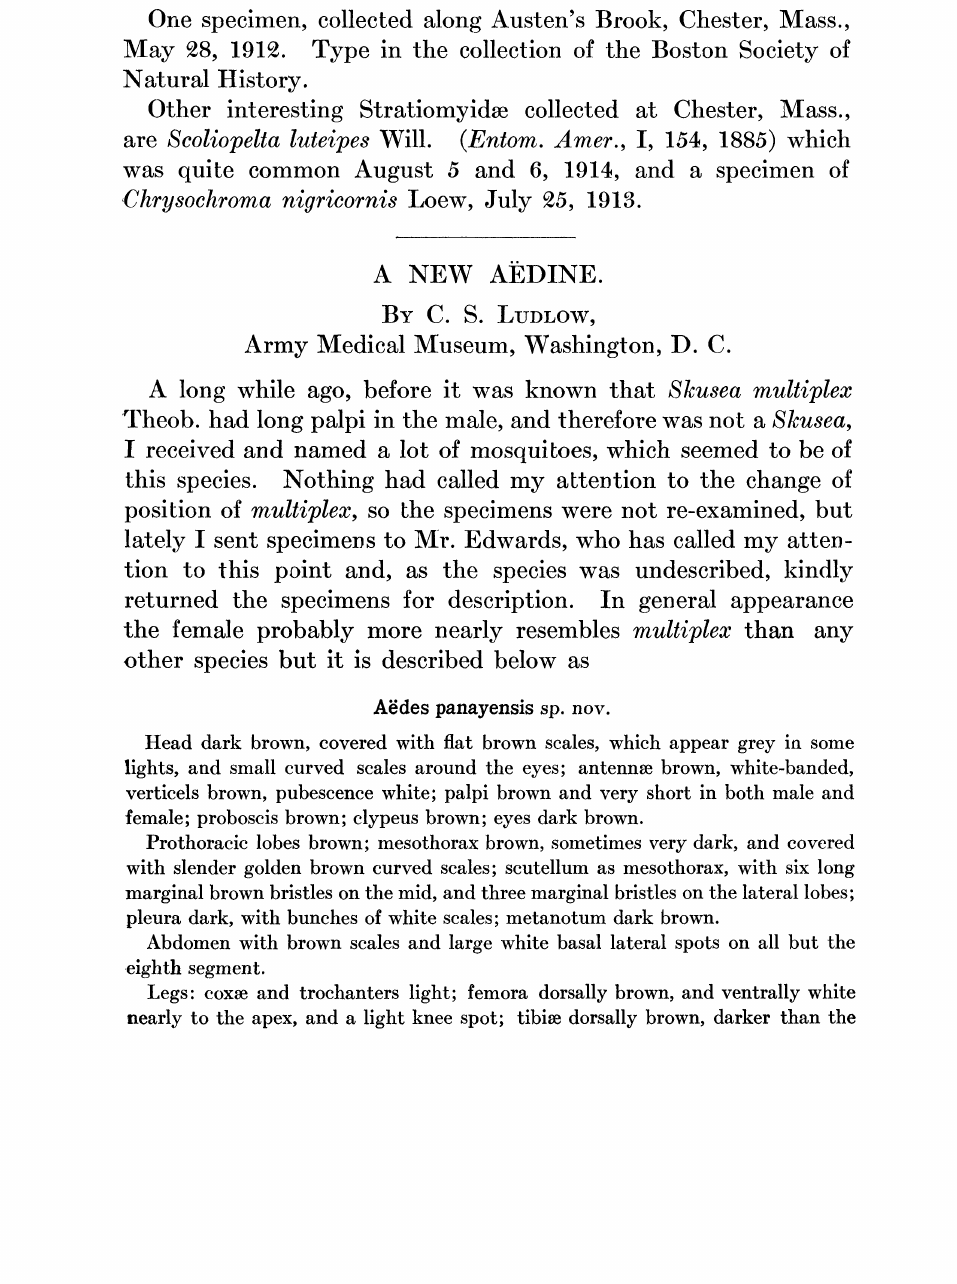
wing. Abdomen broad, about double the width of the thorax, the five segments ,shining, sparsely covered with whitish hairs. Halteres white, base of the knobs and stems brown. Legs black, knees, tips of the tibiae and the tarsi yellow, the last two joints of the latter brownish. Wings hyaline, veins yellowish, three veins extending from the discal cell. Length, 4